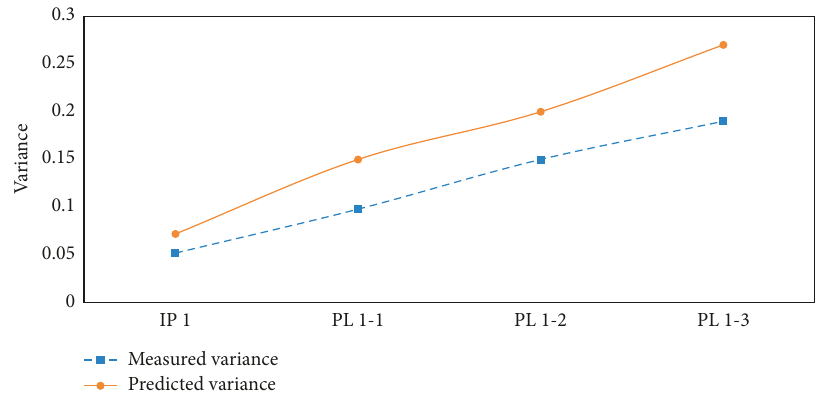
Figure 11: Comparison between the measured variance and the predicted variance.